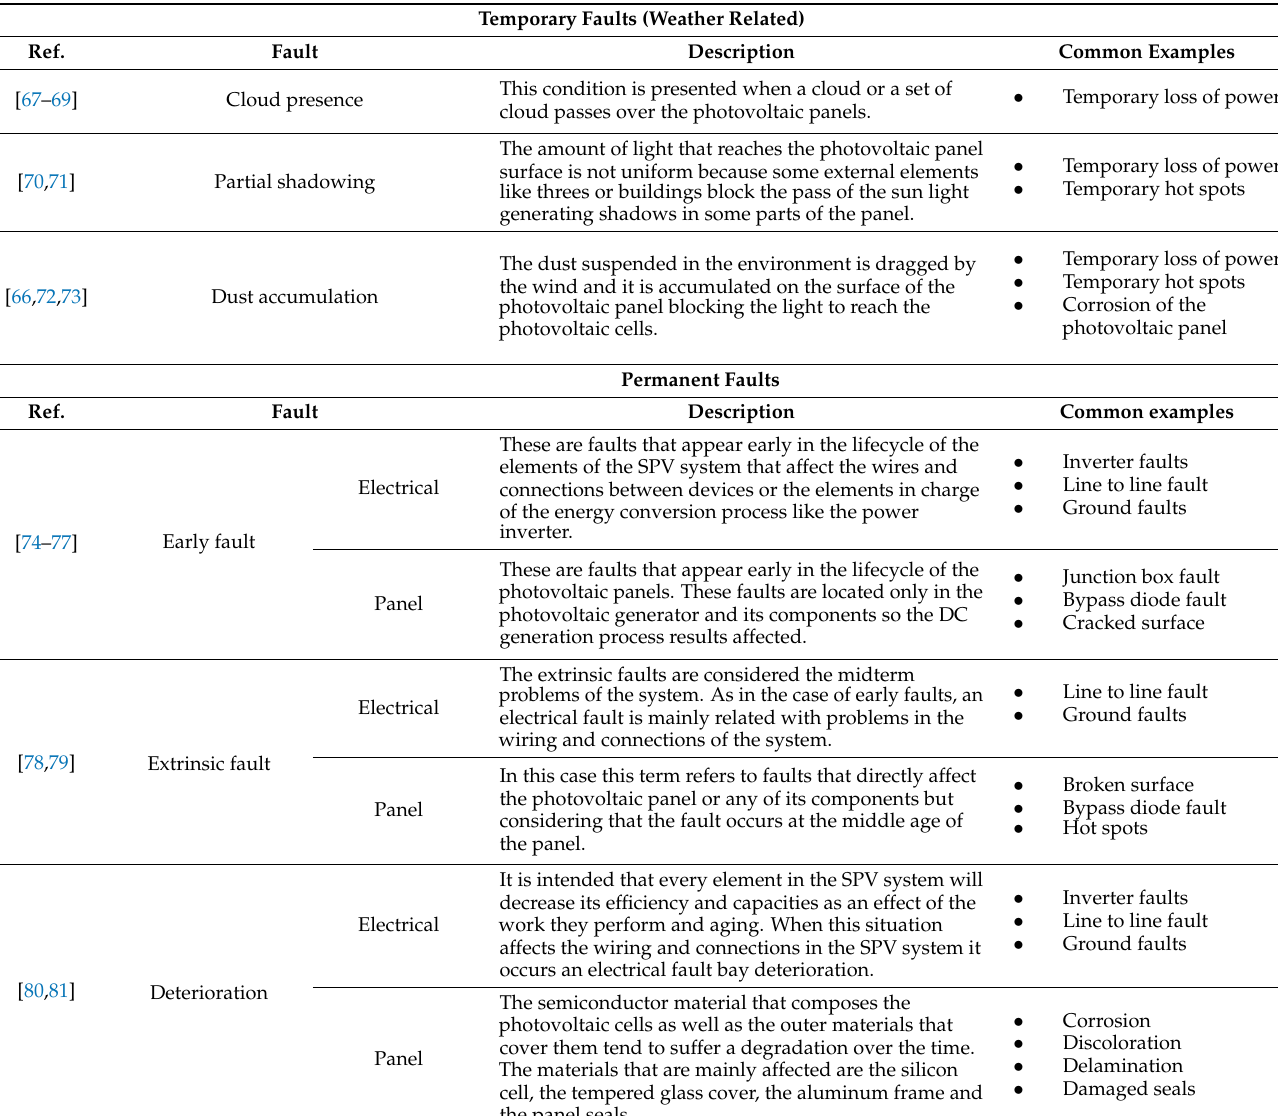
Table 1. Common faults in SPV system and their